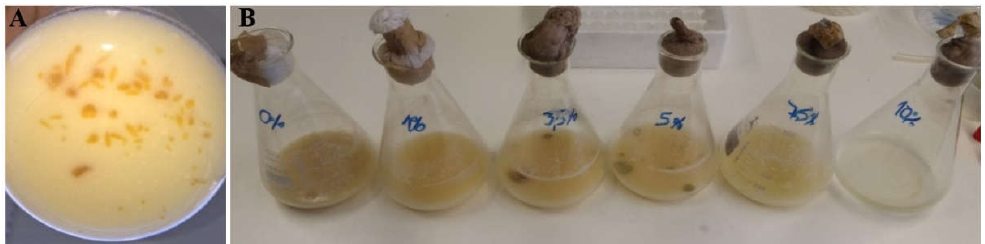
Figure 2. MEL-rich beads formed during later stages of fermentation ( A ). Flasks with different concentrations of NaCl in the fermentation media, after 14 days of fermentation (with the MEL beads present in flasks with 3.5%, 5%, and 7.5%) ( B ).